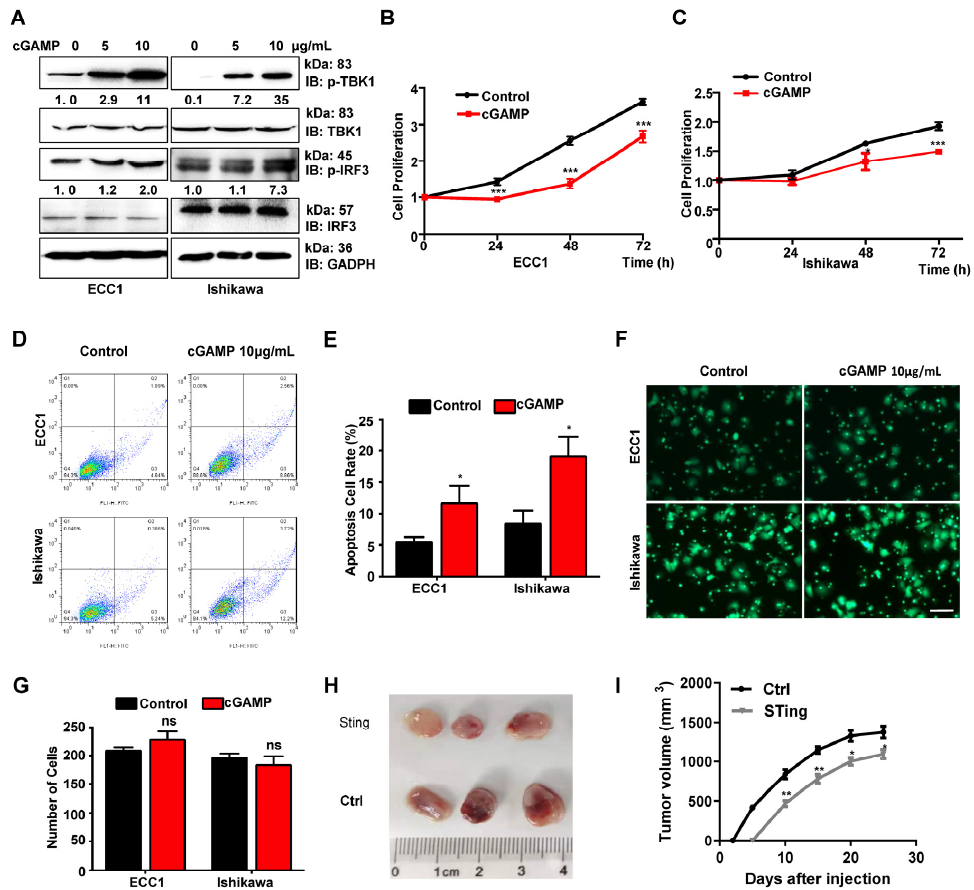
Figure 2. Activated STING inhibits proliferation and facilitates apoptosis in endometrial carcinoma. ( A ) Western blot analysis of the whole cell lysis derived from ECC1 and Ishikawa cells supplemented with 0, 5, or 10 µ g/mL cGAMP in the medium for 4 h. ( B , C ) CCK-8 analysis of the cell proliferation of ECC1 ( B ) and Ishikawa ( C ) cells transfected with 10 µ g/mL cGAMP. ( D ) Flow cytometry analysis of the cell apoptosis of ECC1 and Ishikawa cells transfected with or without 10 µ g/mL cGAMP for 48 h. ( E ) Quantification of apoptosis cells in Figure 2D. ( F ) Representative images of transwell analysis of ECC1 and Ishikawa cells transfected with or without cGAMP (10 µ g/mL). ( G ) Quantification of migrated cells in Figure 2F. ( H , I ) Tumorigenicity of ISK cells and STING overexpression cells detected by morphology ( H ) and xenografts volumes ( I ). The cell-based experiments were repeated at least thrice, and representative results were shown. Data are shown as mean ± SD. Two tails t -tests were used to calculate the p -value. * p < 0.05, ** p < 0.001, *** p < 0.0005 significantly different from Control. Original image of Western blot can be found in File